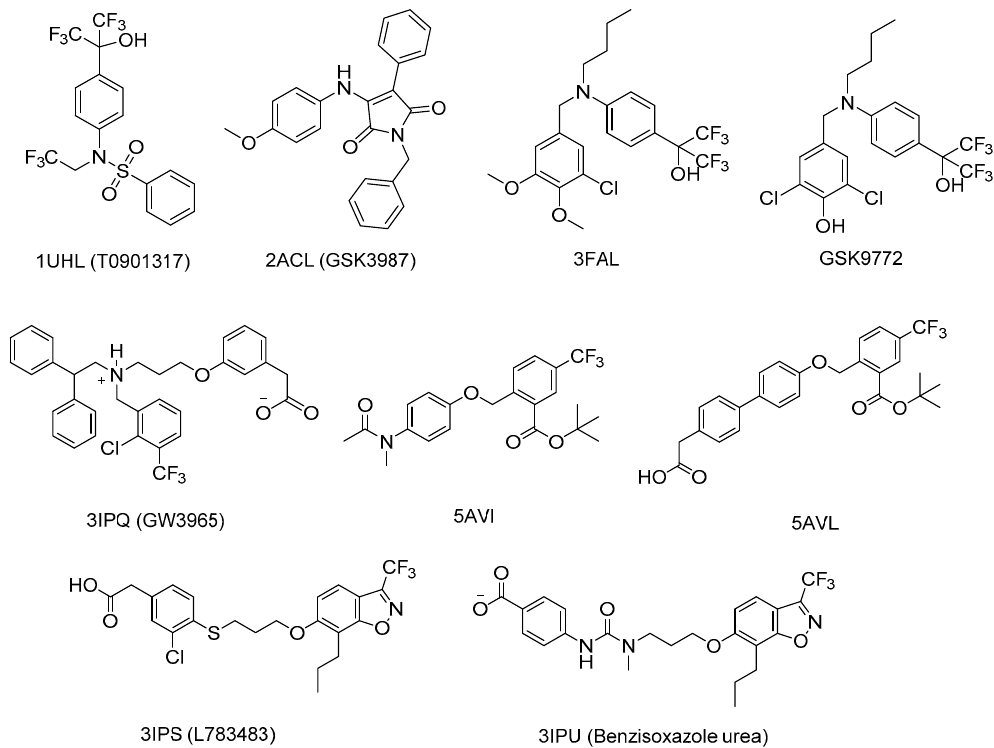
Figure 7. Structures of representative synthetic LXR α ligands.